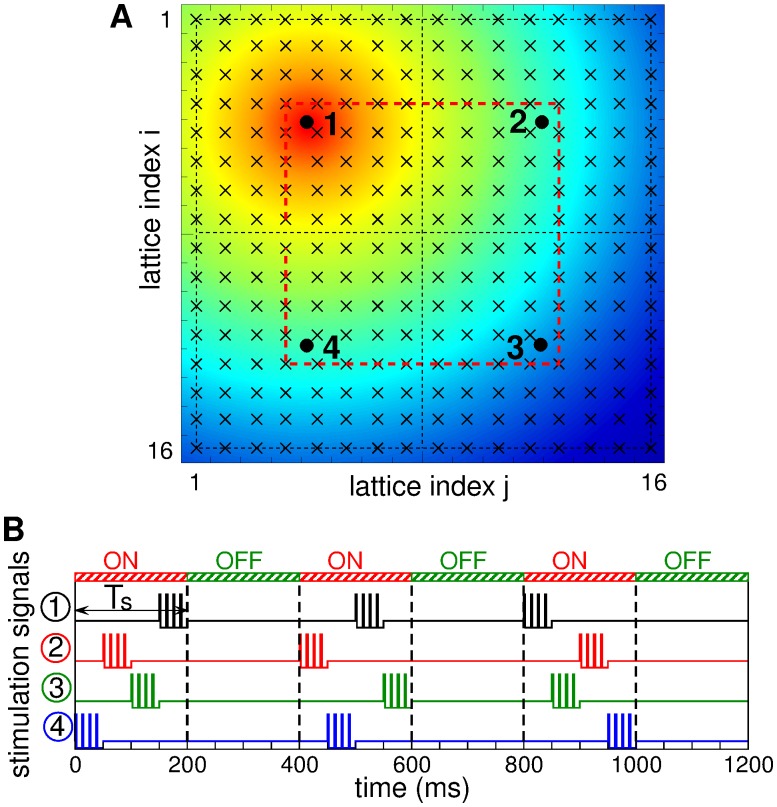
Stimulation setup of CR stimulation.(A) The neurons (marked by crosses) are arranged in a 16 × 16 2Dim lattice, and the stimulation sites (marked by black circles) are placed in the centers of the corresponding quadrants separated by black dashed lines. The spread of the current from the active site 1 for weak stimulation with intensity c = 0.35 is depicted by color. The square red dashed curve indicates a pathway for labeling neurons in the vicinity of stimulation sites. (B) Stimulation signals P
m, m = 1,2,3,4, administered to the neuronal ensemble via each of the four stimulation sites during CR stimulation with stimulation period T
s = 200 ms.